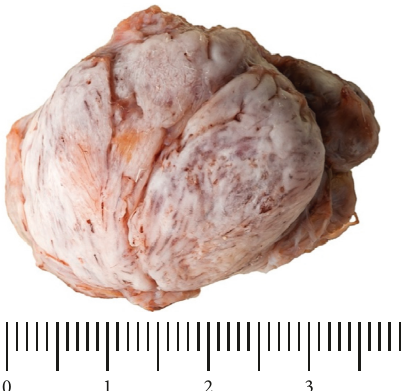
Figure 2: Display of the removed formalin-fixated specimen (37 × 22 × 22mm, 12g, presenting as a round, bony mass smoothly covered by a narrow lamella of connective tissue).